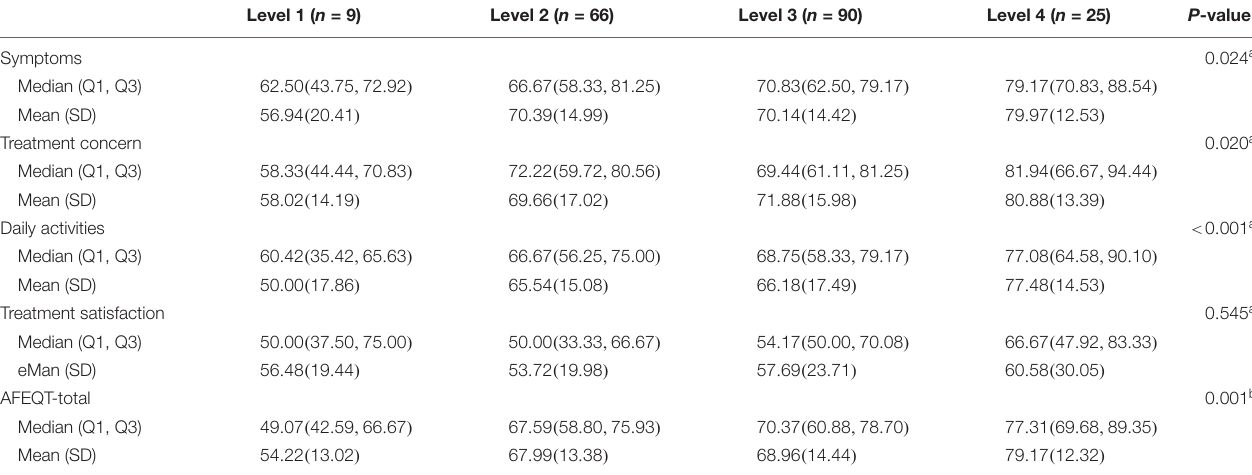
TABLE 5 | AFEQT and subdimensions across PA